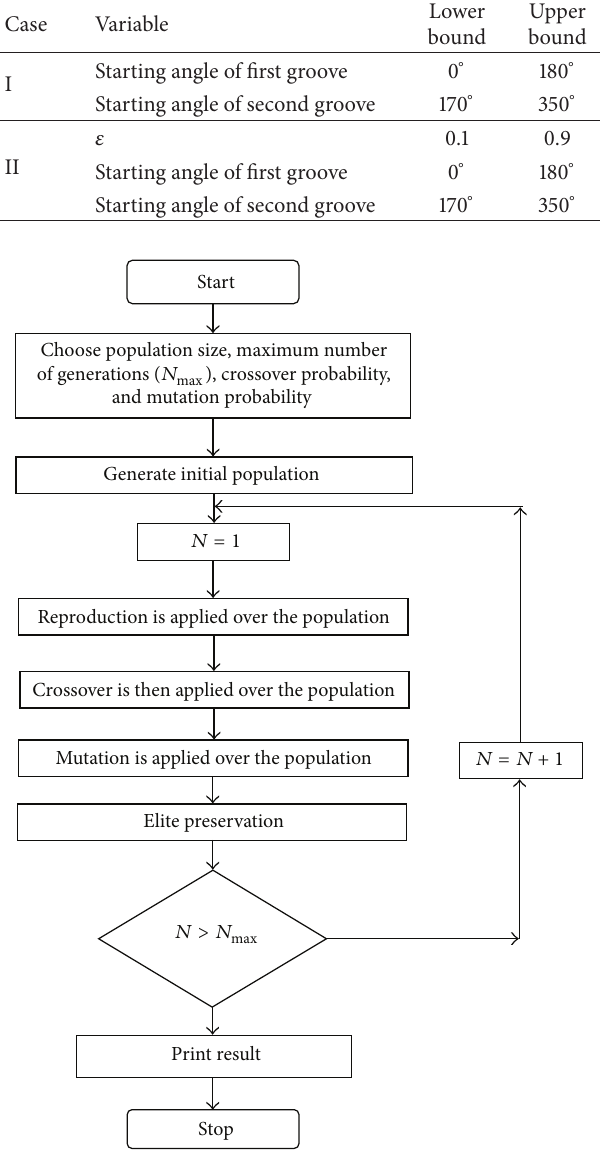
Figure 1: Flow chart for real-coded genetic